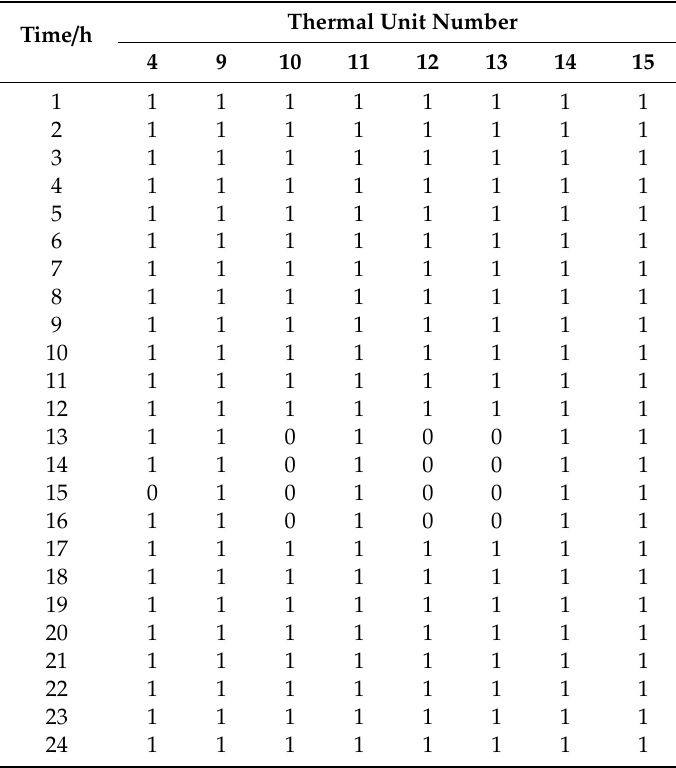
Table 3. Unit commitment solution for the stochastic model.